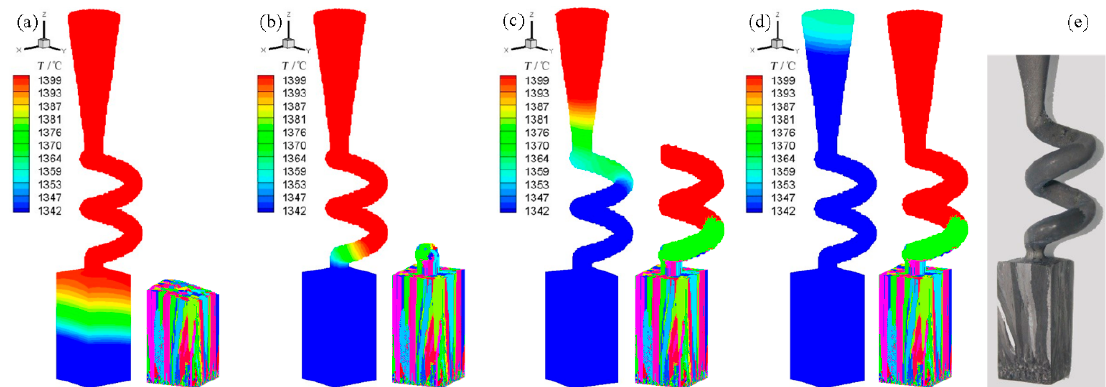
Figure 18. Mushy zone distribution, microstructure simulation results and experiment validation of improved spiral selector ( h s = 14 mm and d s = 12 mm): ( a ) t = 10 min; ( b ) t = 15 min; ( c ) t = 20 min; ( d ) t = 25 min and ( e ) experimental result.